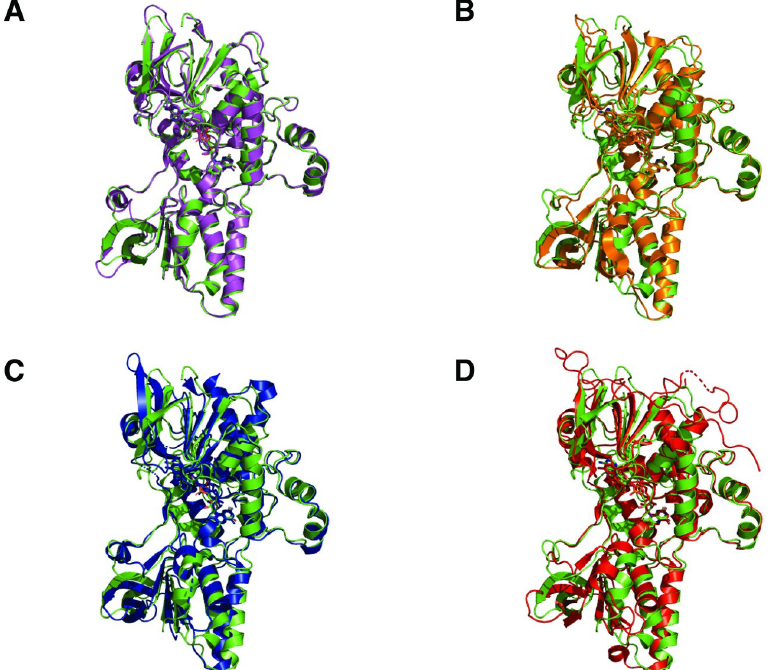
Fig 7. Structural comparison of Ss DesB and homologs. Superimposed crystal structures of chain A of Ss DesB (PDB code: 6XBC) with A) E . amylovora DfoA (PDB code: 5O8P), B) Kutzneria sp. 744 ornithine hydroxylase, Ktzl, (PDB code: 4TM1), C) P . aeruginosa ornithine hydroxylase, PvdA, (PDB code: 3S5W), and D) A . fumigatus ornithine hydroxylase, SidA, (PDB code: 5CKU).